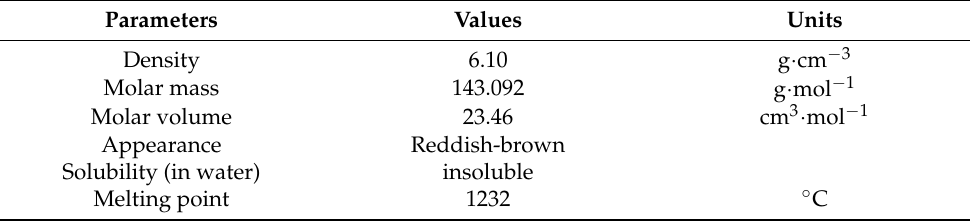
Table 2. General physicochemical properties of Cu 2 O. From the Safety Data Sheet of Cu 2